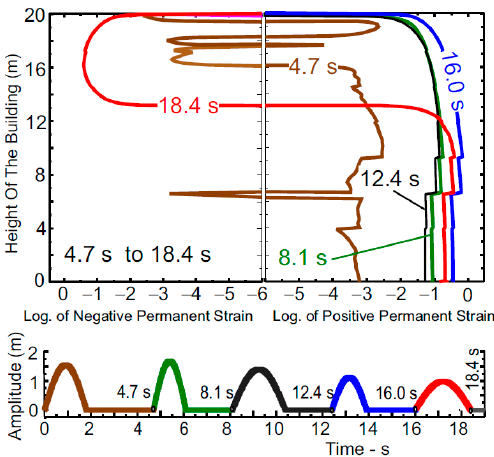
Figure 13. Permanent strains in the building model resulting from a sequence of five pulses. Strains are shown for times during quiescent ground motion just before the onset of the following pulses (at 4.7 s, 8.1 s, 12.4 s, and 16.0 s) and after the fifth pulse at 18.4 s.